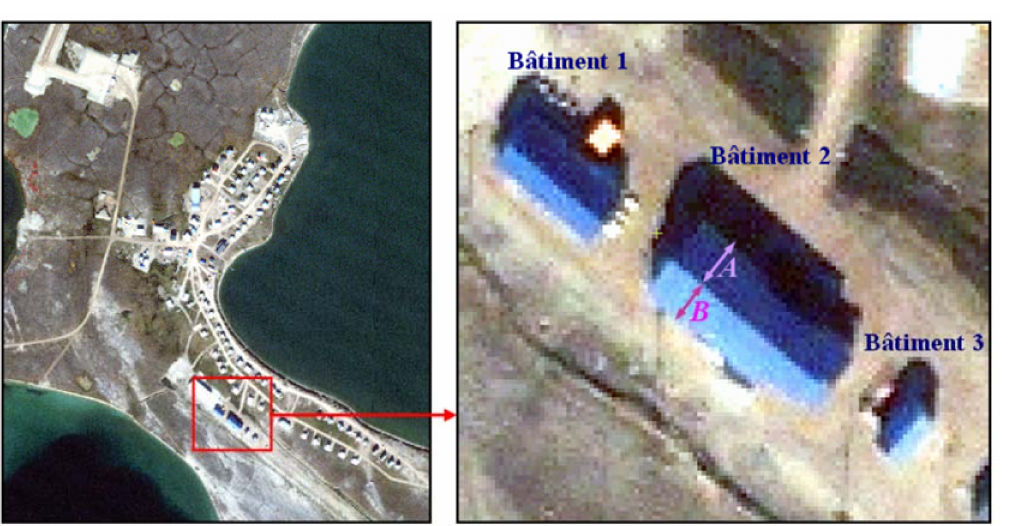
Figure 20. Ikonos image of Paulatuk region de, Nordwest Territories, Canada, showing the illumination difference of tilted rooftops. Scene center is 69 ◦ 20 (cid:48) 30”N, 124 ◦ 04 (cid:48) 00”O; sun zenith angle is 60.06 ◦ ; sun azimuth is 182.75 ◦ ; viewing angle is 25.49 ◦ ; viewing azimuth is 287.78 ◦ ; AOD = 0.05 (very clear